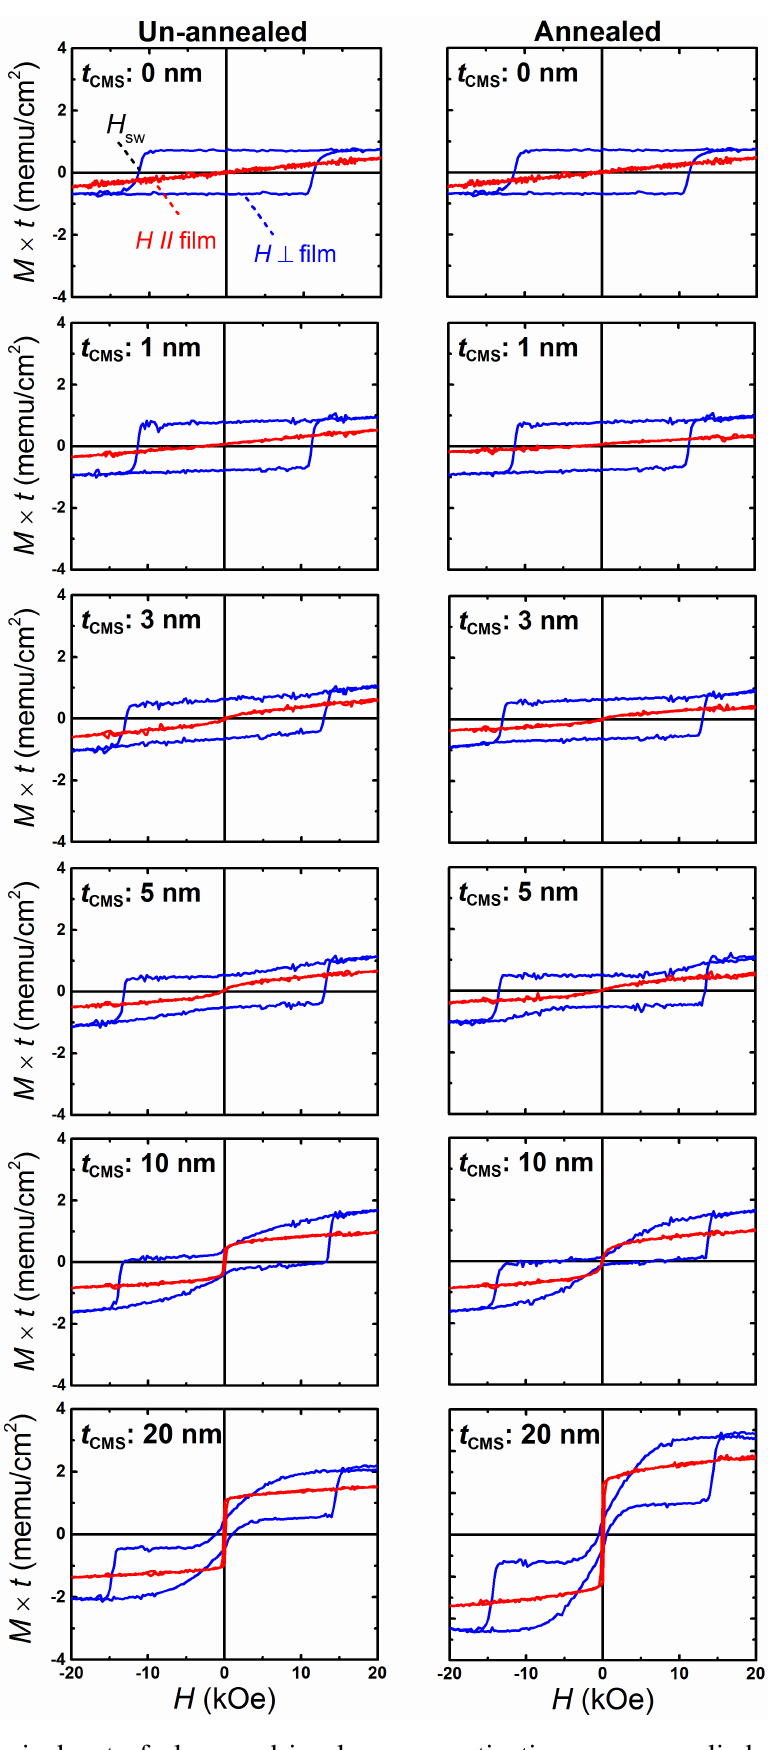
Figure 3. Typical out-of-plane and in-plane magnetization versus applied magnetic field ( M - H loop) of CMS (0–20 nm)/MnGa (30 nm) bilayers for the un-annealed (left figures) and annealed (right figures) samples measured by vibrating sample magnetometer